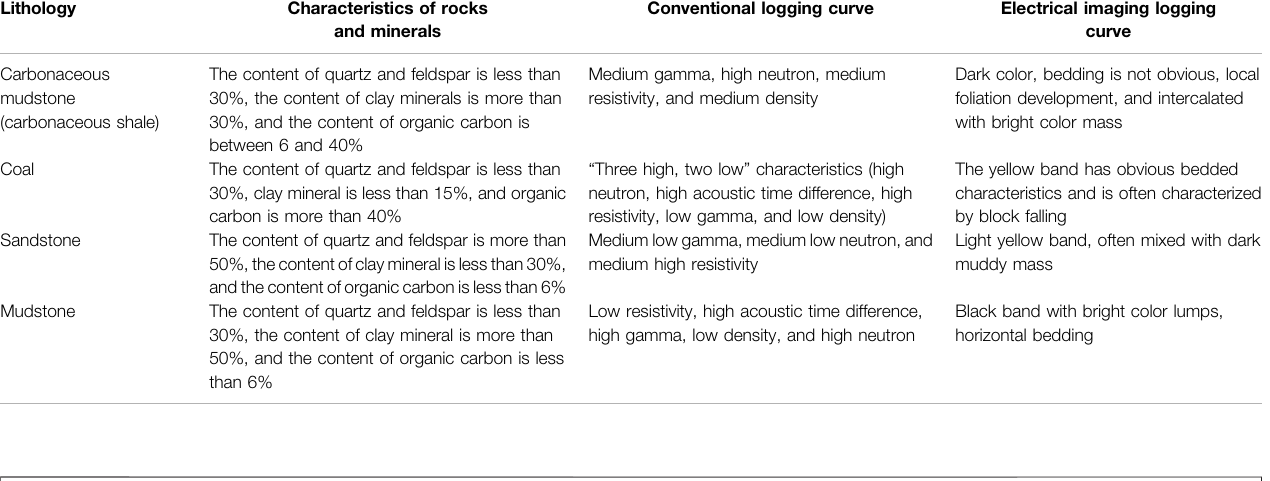
TABLE 1 | Statistics of lithology and logging characteristics of carbonaceous mudstone, coal, sandstone, and mudstone. Lithology